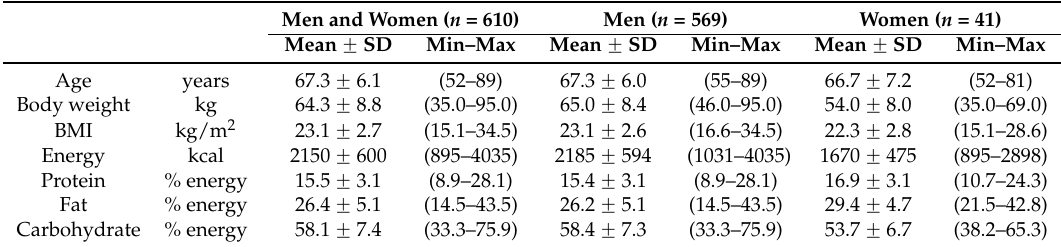
Table 1. Characteristics of the population (569 men and 41 women) and their nutritional